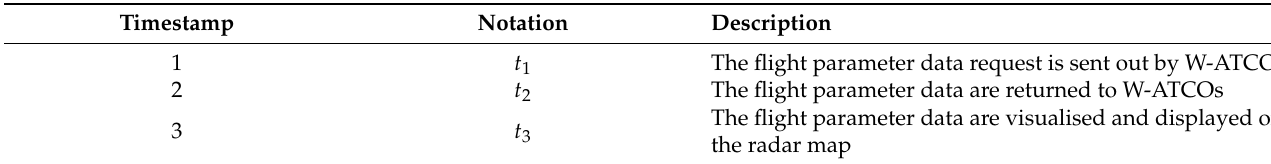
Table 2. Timestamp snapshotted for latency measurement.